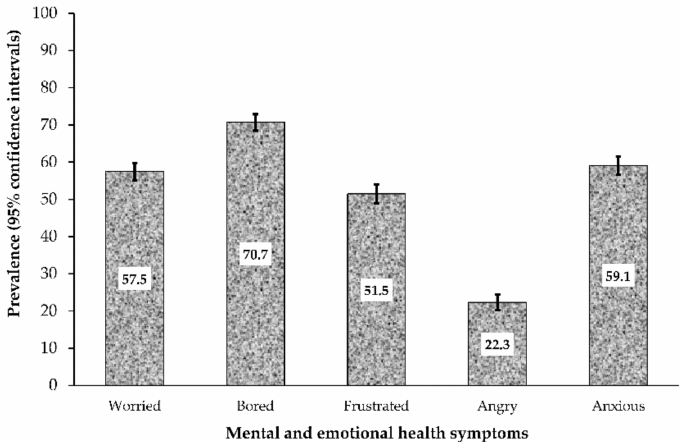
Figure 1. Prevalence of mental health and emotional effects in Sub Sahara African respondents ( n = 2005) during the COVID-19 Pandemic. Error bars are 95% confidence